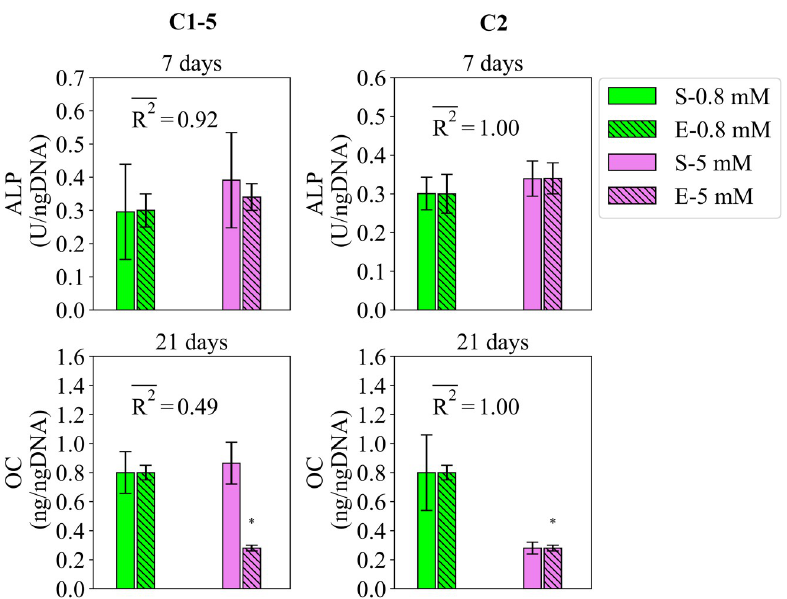
Fig 3. Fits of the model calibrated by C1-5 and C2 to the empirical data of study 2. Bars indicate the simulations (S-) and the corresponding empirical data (E-) for increasing Mg 2+ ion concentrations. The quantities of ALP and OC are reported at day 7 and 21, repectively. The error bars on the empirical data shows the standard deviations. The error bars on the simulation results show the standard deviations obtained during SSIP, i.e. 15% alteration in the estimated parameter values. Stars indicate the statistically significant differences between values given for the empirical data compared to the control, i.e. Mg 2+ ion concentration of 0.8 mM (p < 0.05 = � ). R 2 is the average fitness value of the simulations for the given measurement item.